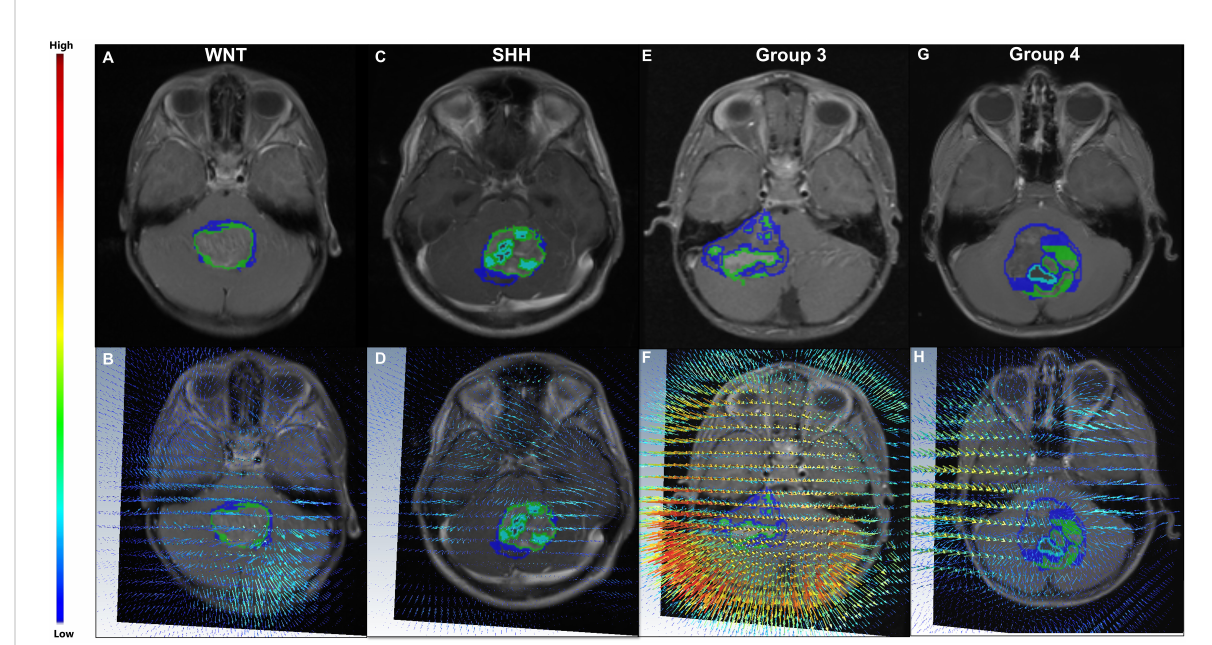
FIGURE 3 (Top) Four MB subjects representing the four MB molecular subgroups, WNT (A) , SHH (C) , Group 3 (E) , and Group 4 (G) , respectively. The corresponding deformation magnitude maps for each of the four molecular sub-types are provided in (B, D, F, H) respectively. For the patient with Group 3 (the most aggressive subgroup) (E) , higher magnitude values (represented in red) were observed in close proximity of the tumor (F) , whereas lower values were observed (blue) in (B) for the patient with WNT (the least aggressive subgroup) (A)